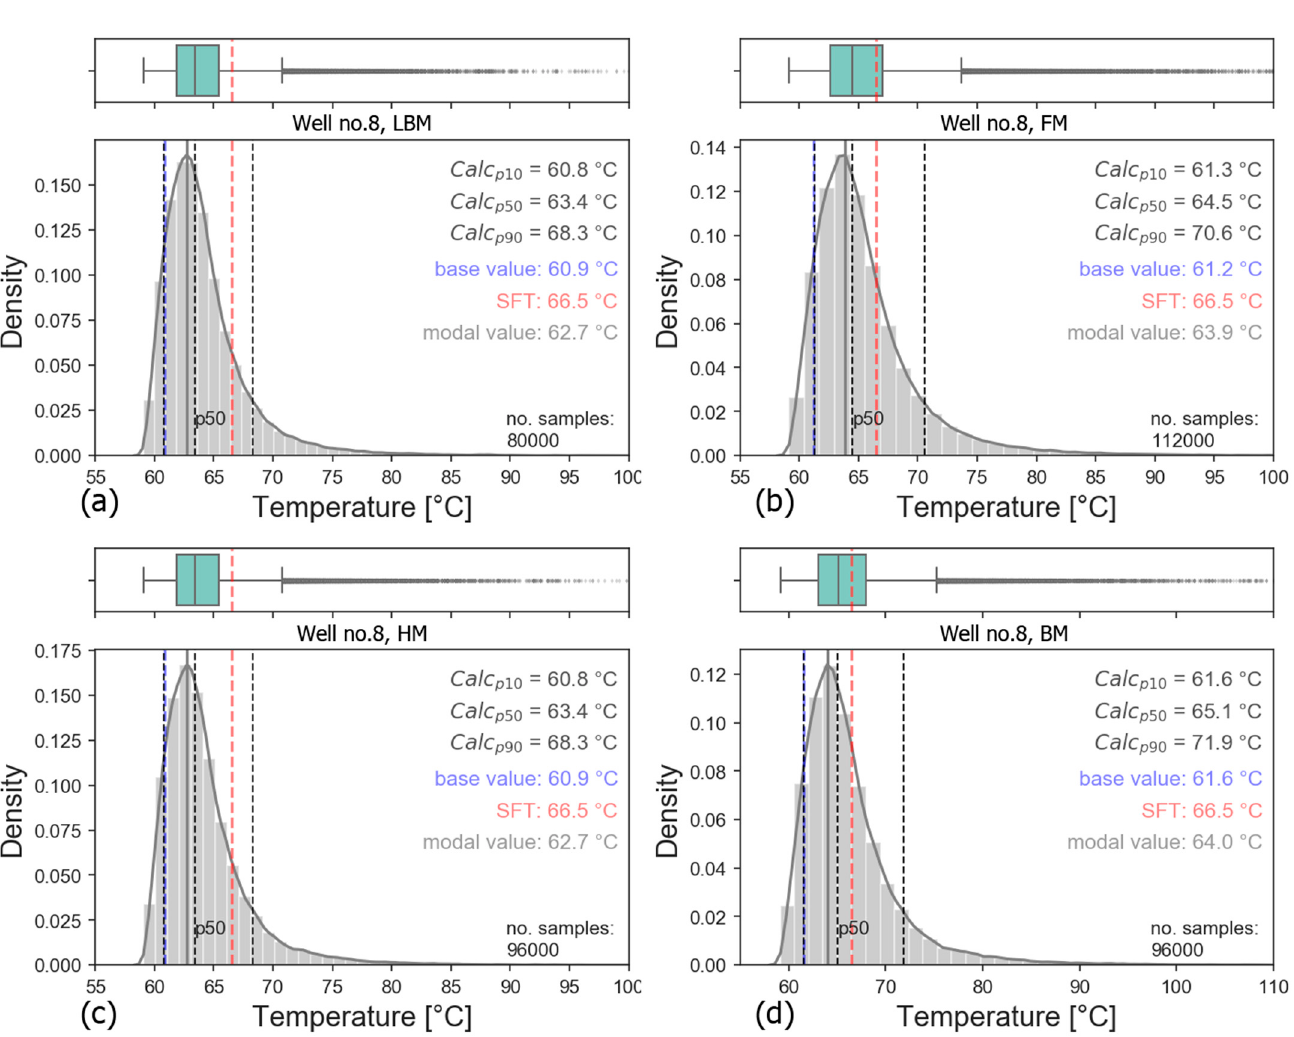
Figure 11. Distribution of corrected SFT at well no. 8 for five conventional methods ( a ): Lachenbruch and Brewer method LBM, ( b ): Forward modeling FM, ( c ): Horner plot method HM, ( d ): Brennand method BM. The SFT has been read from an undisturbed TLog with a shut-in time of approximately 2 years. A boxplot is included above every subplot with the SFT as the red dashed line.